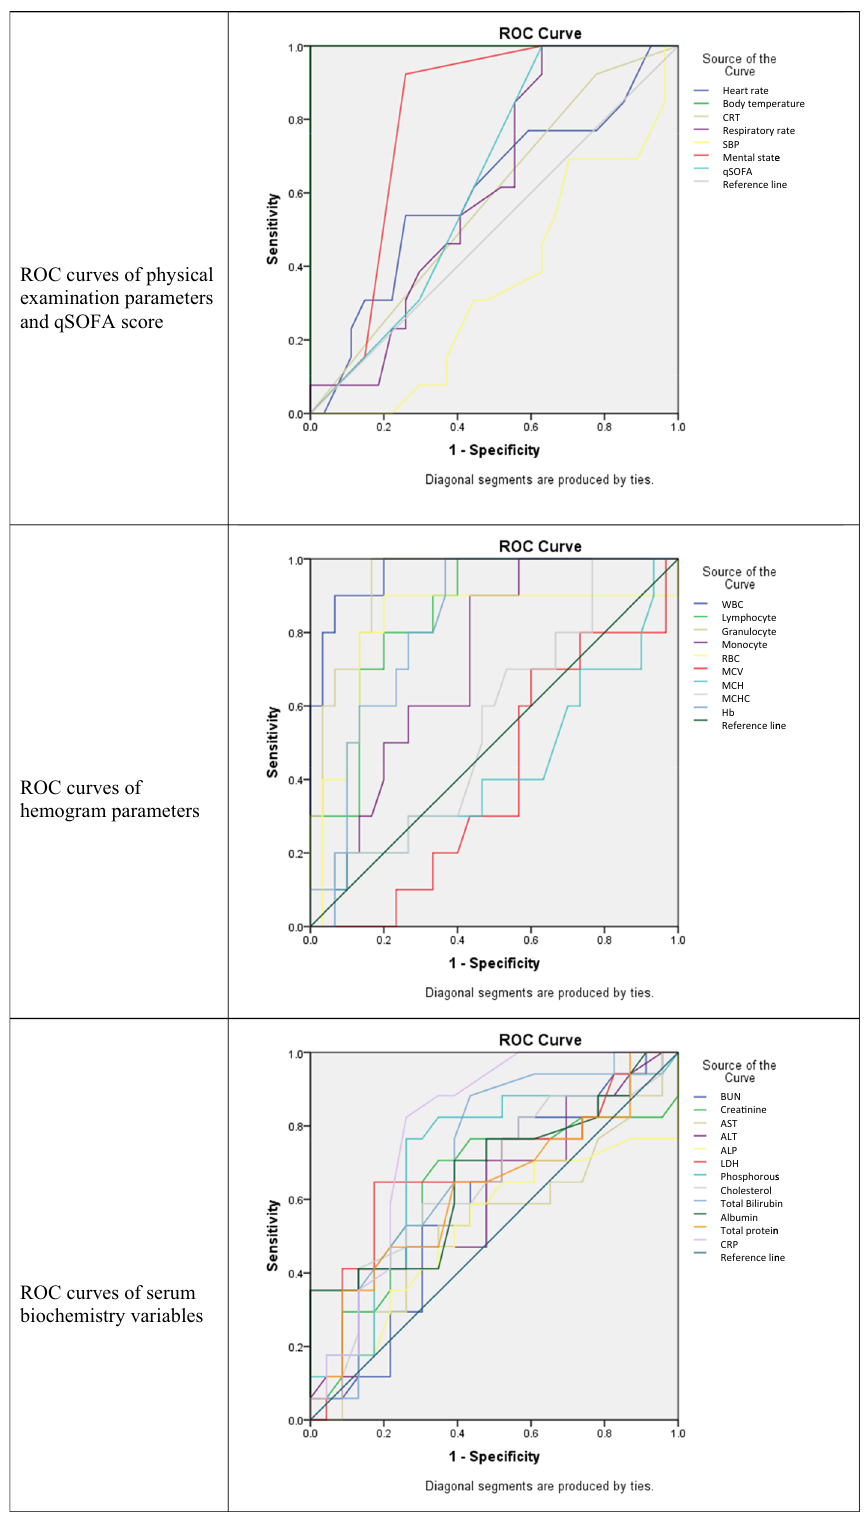
Figure 1: ROC curves of clinical fi ndings, hemogram and serum biochemistry